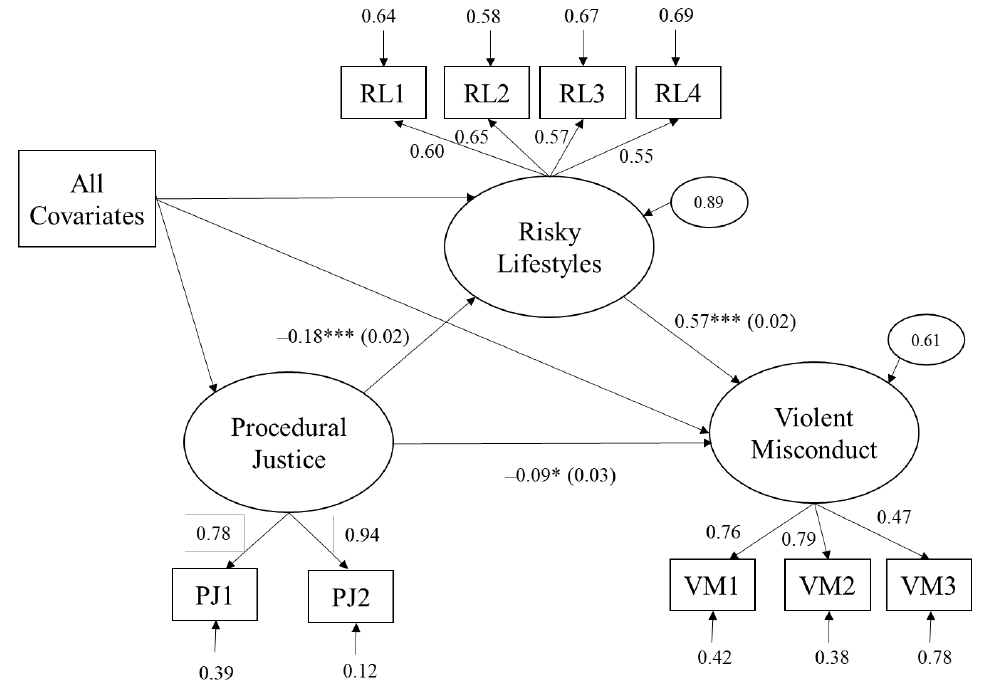
Figure 1. The structural model with standard coefficients. All the covariates were included but shown with a single rectangle. Standard errors for regression coefficients were shown in parentheses. χ 2 = 138.445, df = 72, p < 0.001; GFI = 0.979; CFI = 0.984; and RMSEA = 0.029, 95% CI = [0.015, 0.043]. PJ1 =